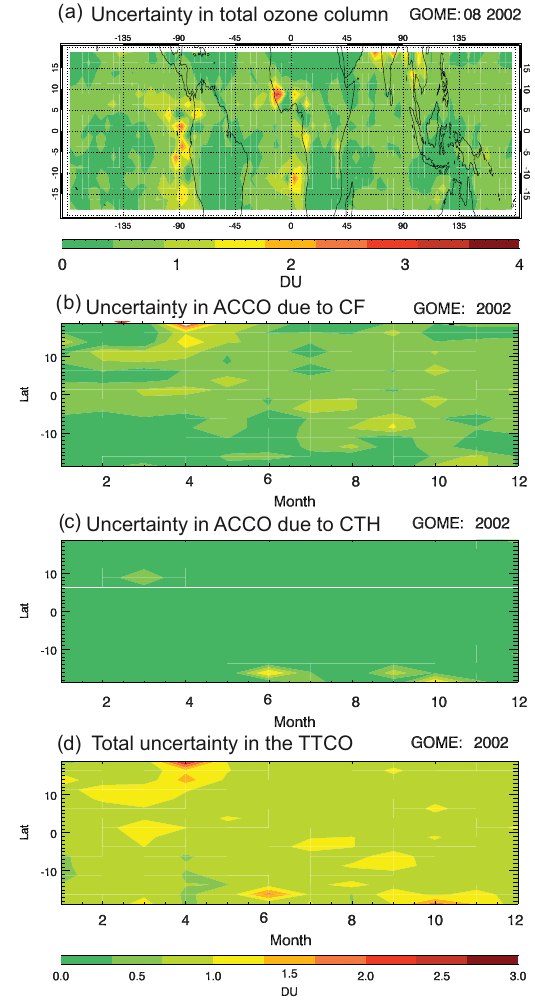
Figure 5. (a) The uncertainty in the WFDOAS TCO retrieval in Au- gust 2002 using GOME (b) the uncertainty in the monthly averaged zonal ACCO due to CF for 2002 using GOME data (c) the uncer- tainty in the monthly averaged zonal ACCO due to CTH for 2002 using GOME data (d) the total uncertainty in the TTCO using the CCD method and GOME WFDOAS total ozone data in